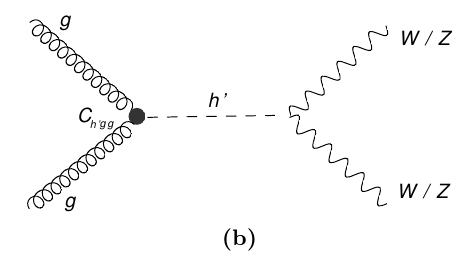
Figure 7. The dominant production and decay channels for the beyond the MSSM bosons. (a) Heavy quark fusion production of Z 0 . (b) Gluon fusion production of h 0